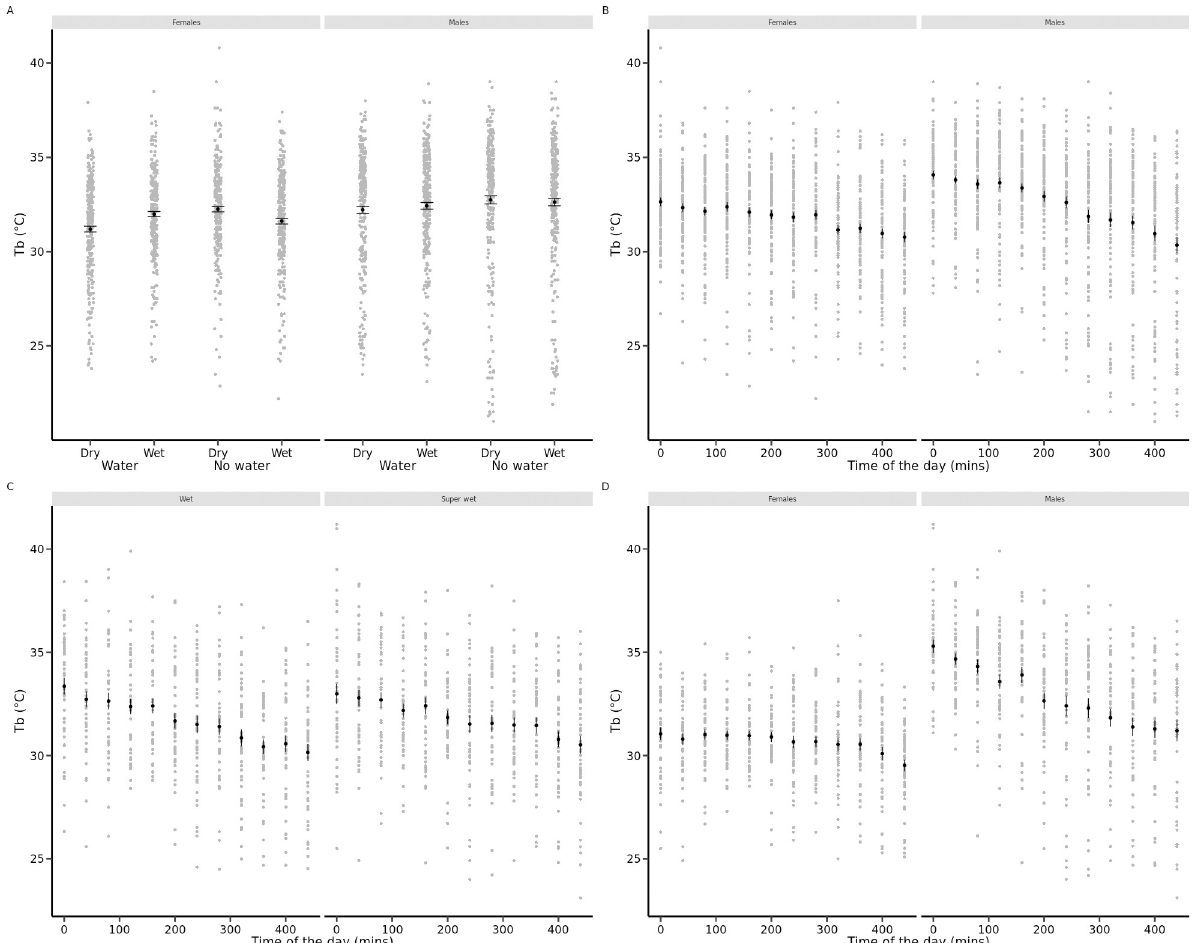
Fig 2. Individual records of body temperatures (T b , ˚C) of yearling common lizards during daytime. A. Mean, standard errors and dotplots for female and male lizards in neutral arenas from Experiment 1 as a function of availability of free-standing water and air humidity (dry: VPD = 10.66 kPa, wet: VPD = 0.46 kPa). B. Mean, standard errors and dotplots for female and male lizards in neutral arenas from Experiment 1 per daytime period. C. Mean, standard errors and dotplots for lizards of both sexes in neutral arenas from Experiment 2 per daytime period in each air humidity treatment (wet: VPD = 0.70 kPa, super wet: VPD = 0.12 kPa). D. Mean, standard errors and dotplots for female and male lizards in neutral arenas from Experiment 2 per daytime period.